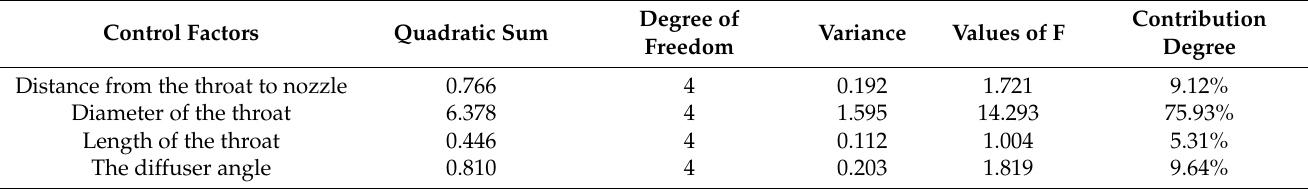
Table 13. Variance analysis of control